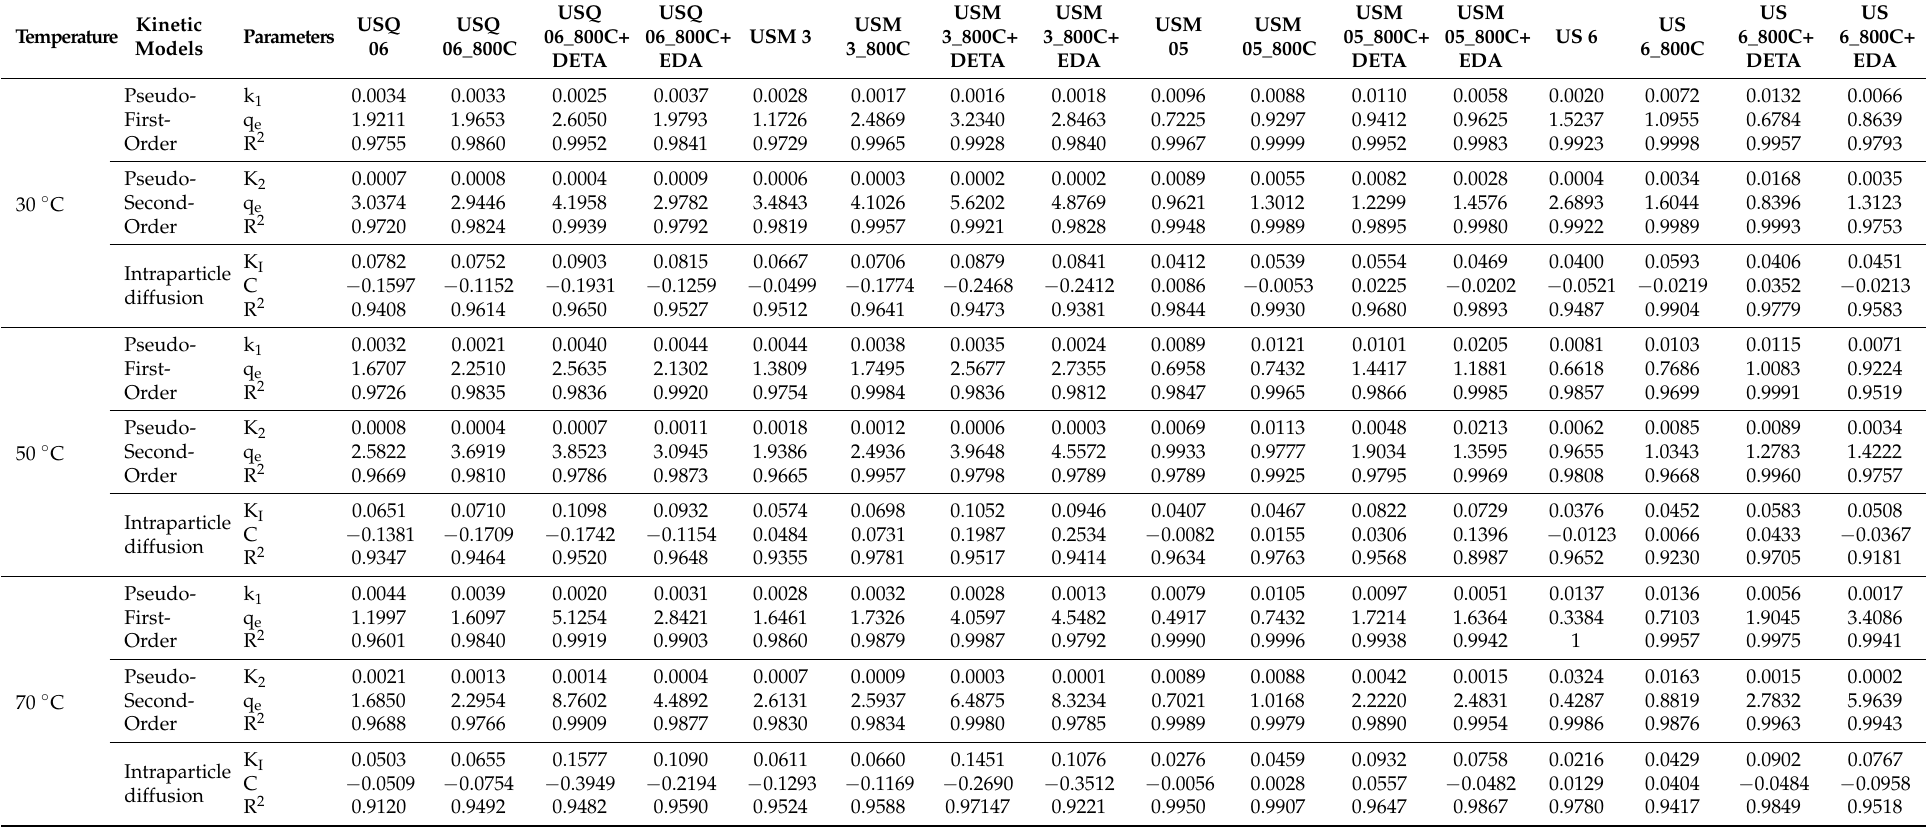
Table 6. The sorption kinetics’ parameters obtained from the experimental data at 30 ◦ C, 50 ◦ C, and 70 ◦